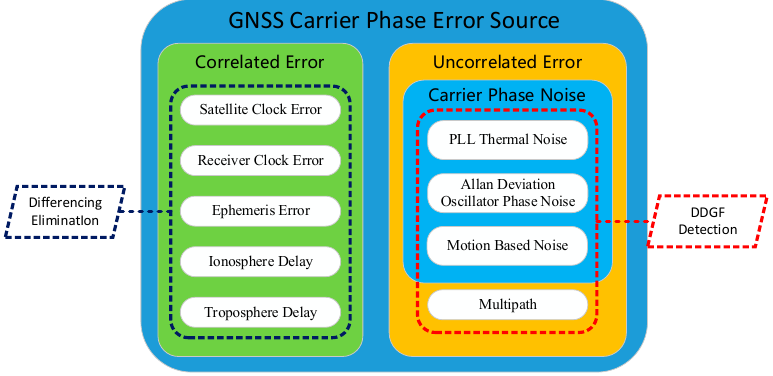
Figure 1. The relationship between the double-differenced geometry free (DDGF) detection and the GNSS carrier phase error sources.